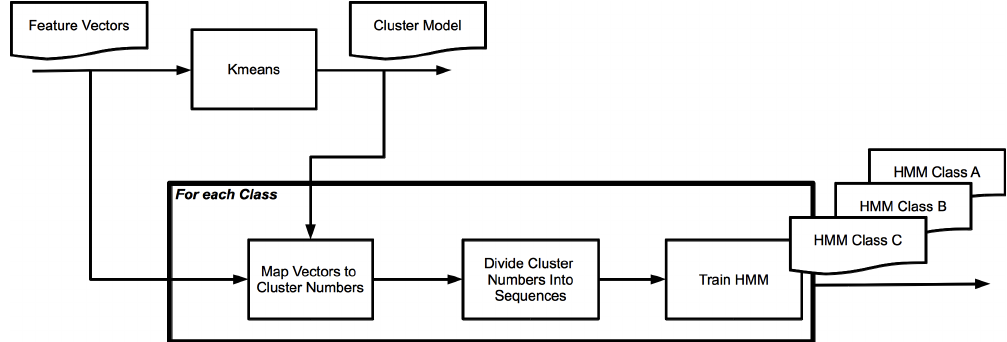
Figure 2. k -means and Hidden Markov Model (KHMM)